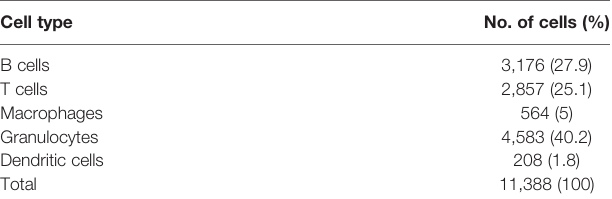
TABLE 1 | Identi fi ed cell types and the corresponding cell numbers (percentages) in Nile tilapia anterior kidney leukocytes. Cell